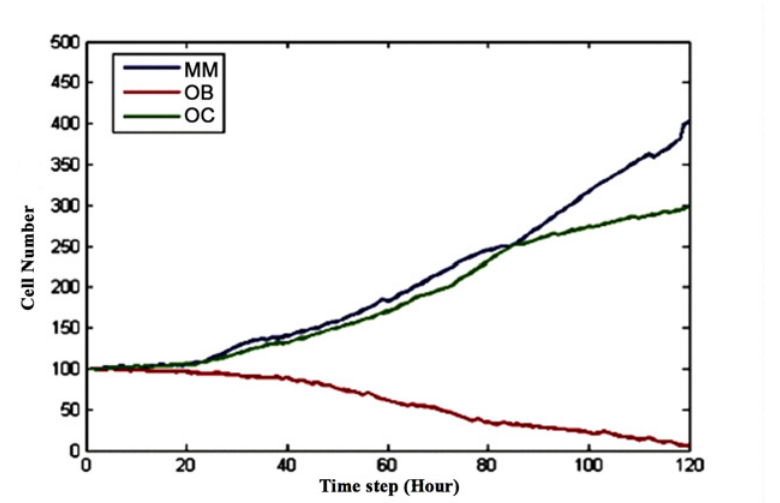
Fig 4. The dynamics of OBs, OCs and MMs without drug